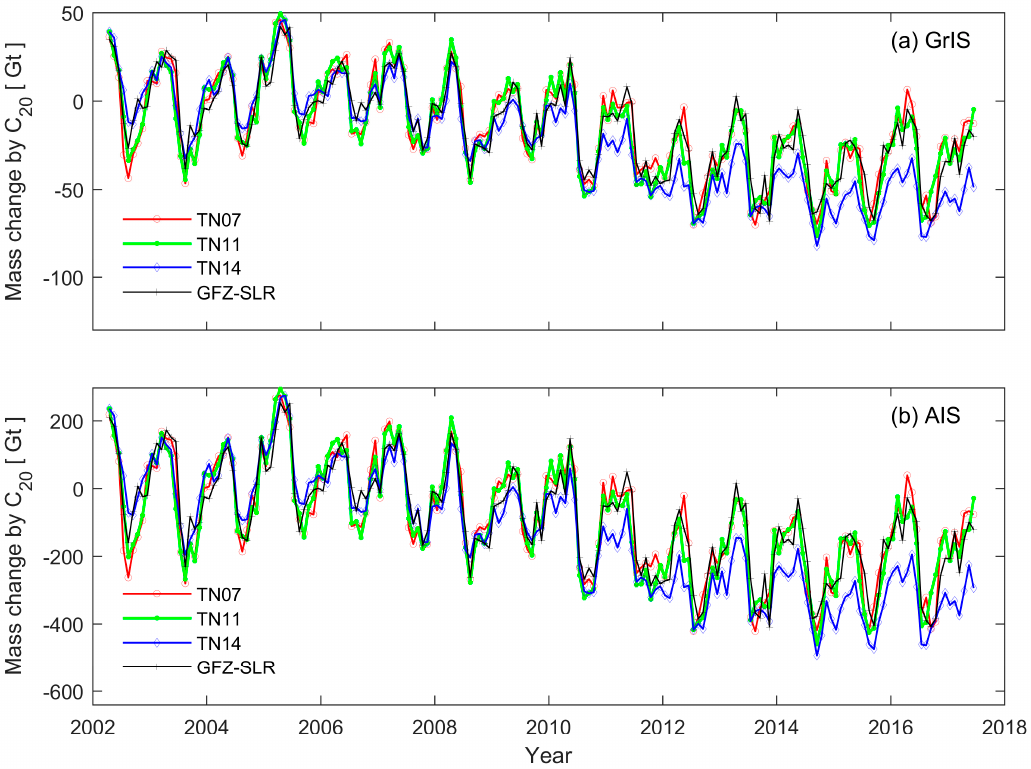
Figure 3. Mass change time series computed by only using SLR-based C 20 estimates from TN07, TN11, TN14, and GFZ over ( a ) the GrIS and ( b ) the AIS during the GRACE mission span. Table 3. The linear trend, annual amplitude and annual phase of mass change time series caused by SLR-based C 20 estimates over the GrIS and the AIS during the time span from August 2002 to July 2016, using SLR-based C 20 estimates in TN07, TN11, TN14, and GFZ.